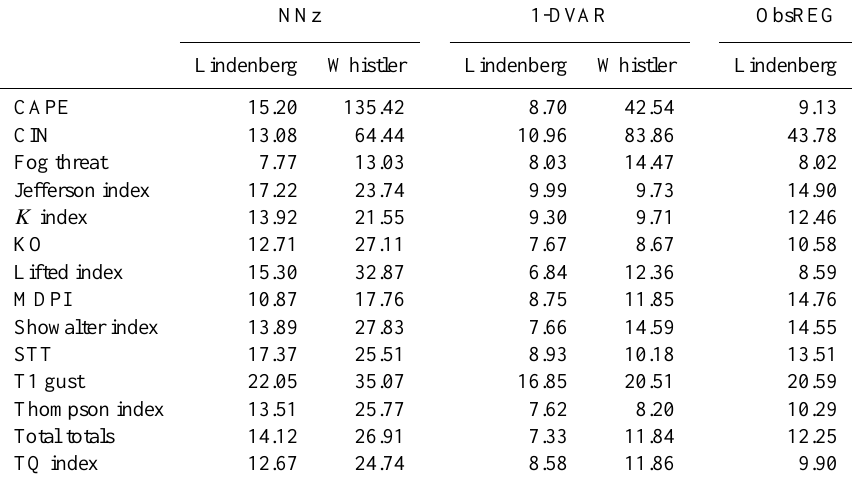
Table 4. Summary of normalized rms (NRMS) difference (i.e. rms divided by the range of observed values) between the FIs computed from radiosonde and MWRP retrievals, for all the retrieval methods and data sets given in Tables 2–3. NRMS is expressed in percentage